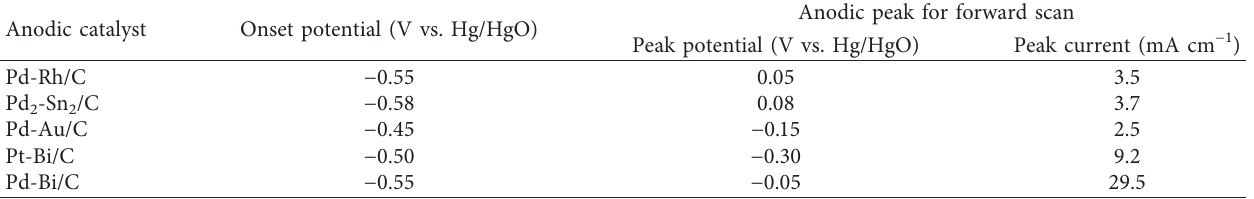
Table 1: Comparison of glucose oxidation reaction (GOR) performance between different binary Pd-based catalysts.